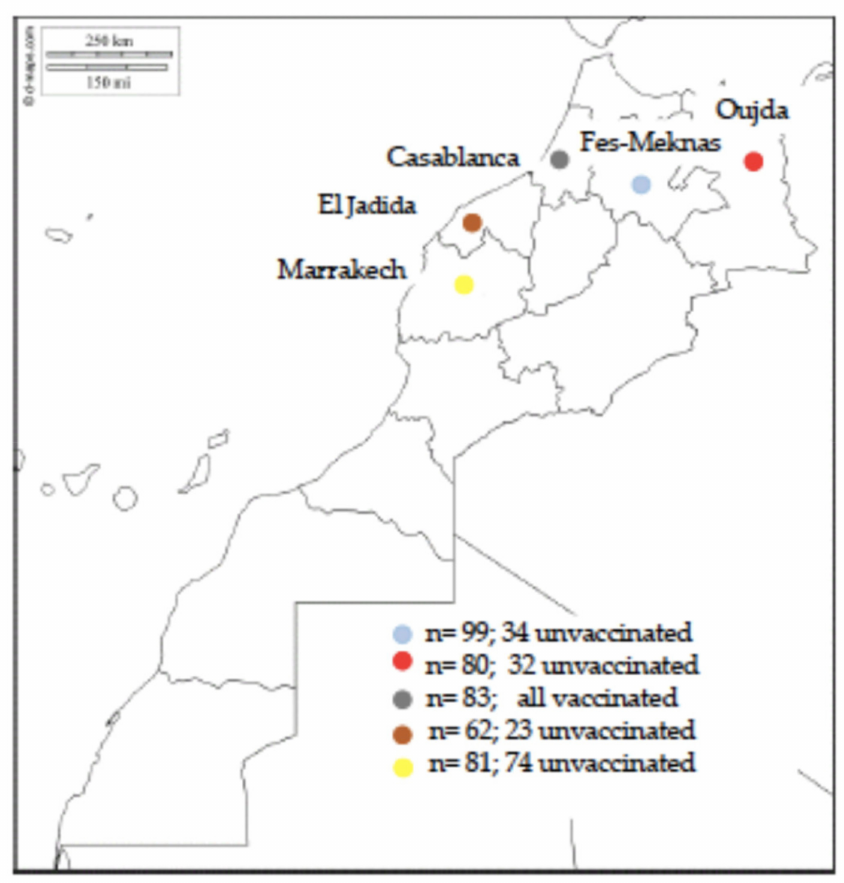
Figure 1. Geographical distribution of sampled regions in Morocco map.